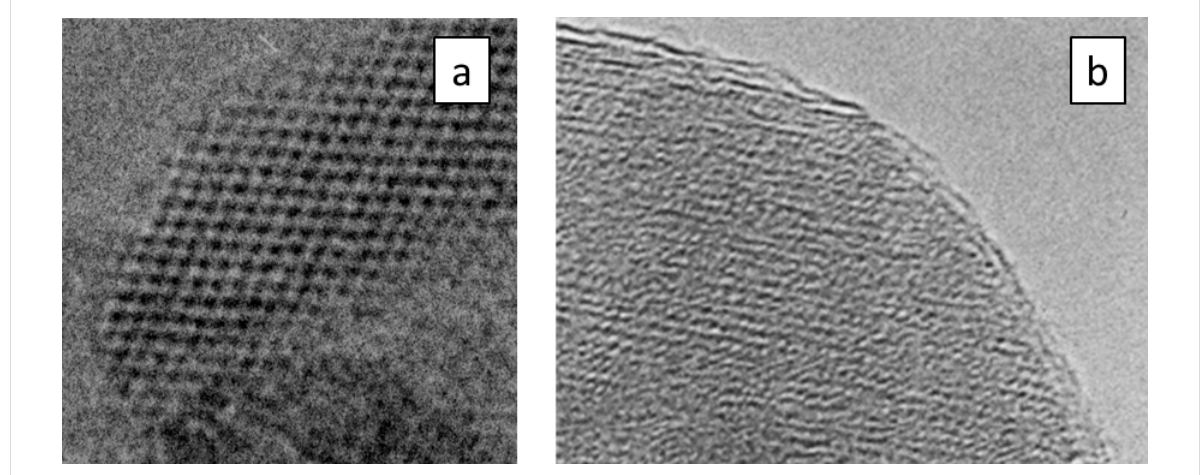
Figure 14: High-resolution electron micrograph of a zirconia, ZrO 2 , and an alumina, Al 2 O 3 nanoparticles. (a) A perfectly (up to the surface) crystal- lized zirconia particle [55]. In contrast, the alumina particle displayed in (b) shows that the lattice fringes do not continue to the surface of the particle [56].